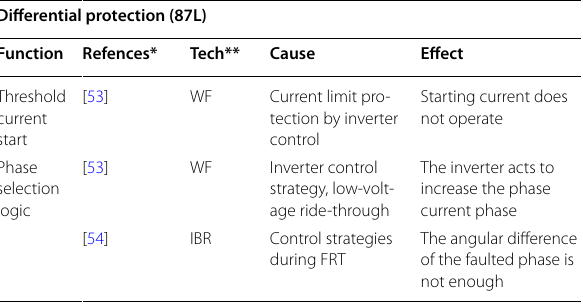
Table 7 Causes and effects on differential protection due to IBRs